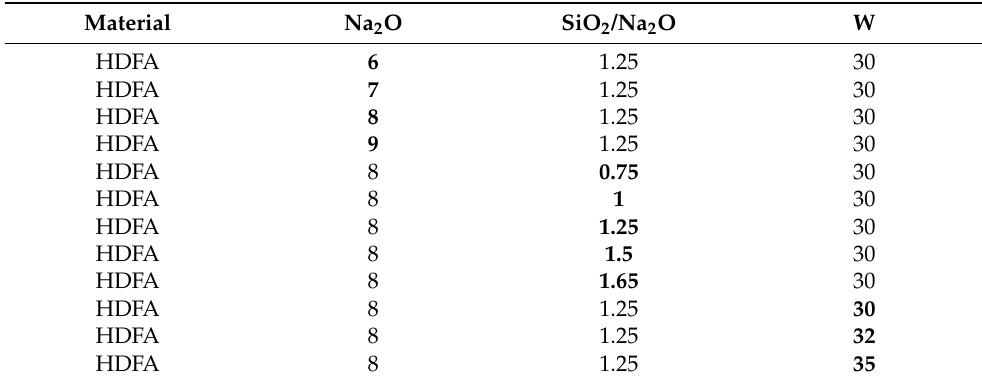
Table 3. Design of